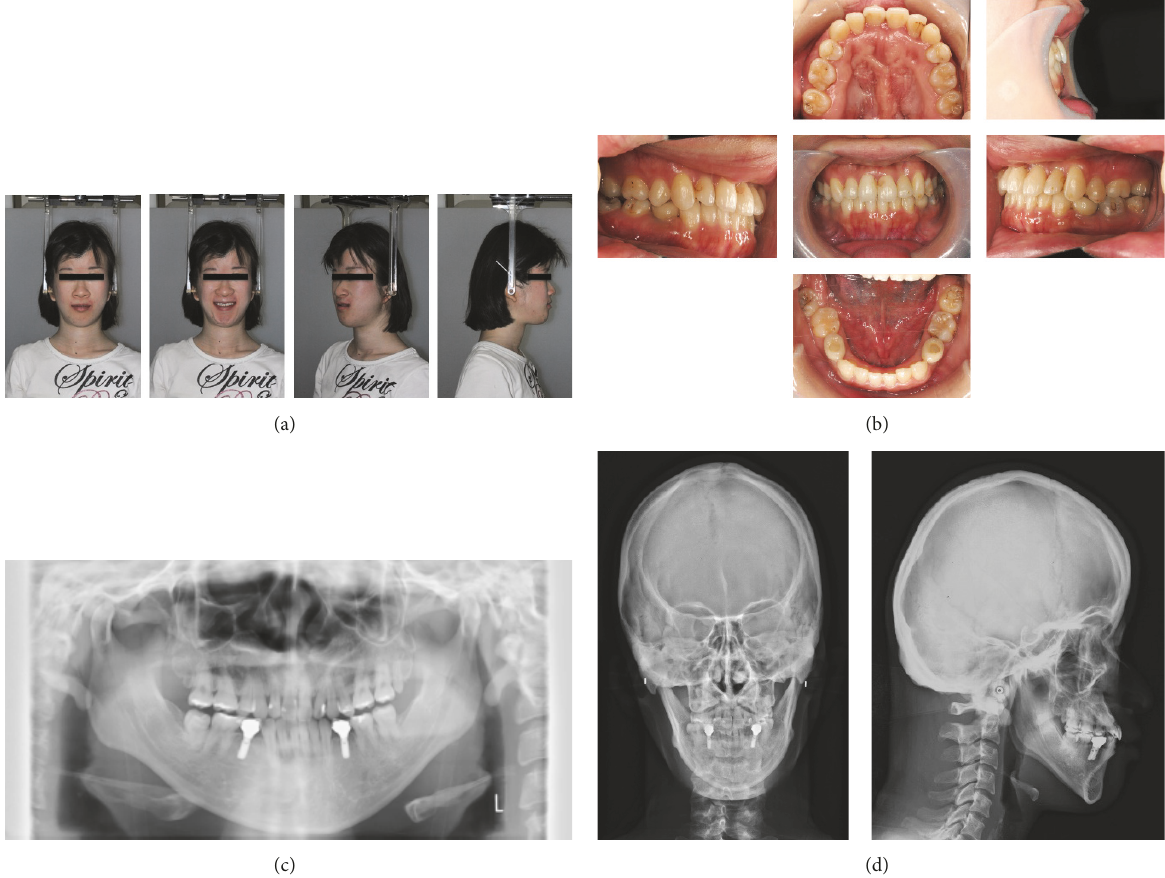
Figure 8: Extraoral and intraoral photographs at 2 years and 8 months after debonding (24 years and 9 months). (a) Extraoral photographs. (b) Intraoral photographs. (c) Orthopantomograms. (d) Posteroanterior and lateral